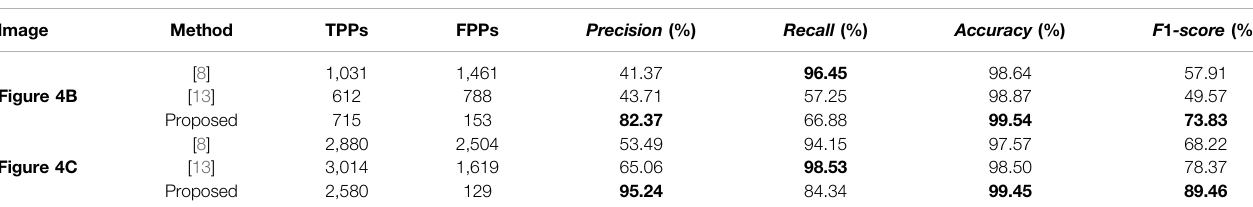
TABLE 1 | Comparison between TPPs, FPPs, Precision , Recall , Accuracy , and F 1 -score . Image